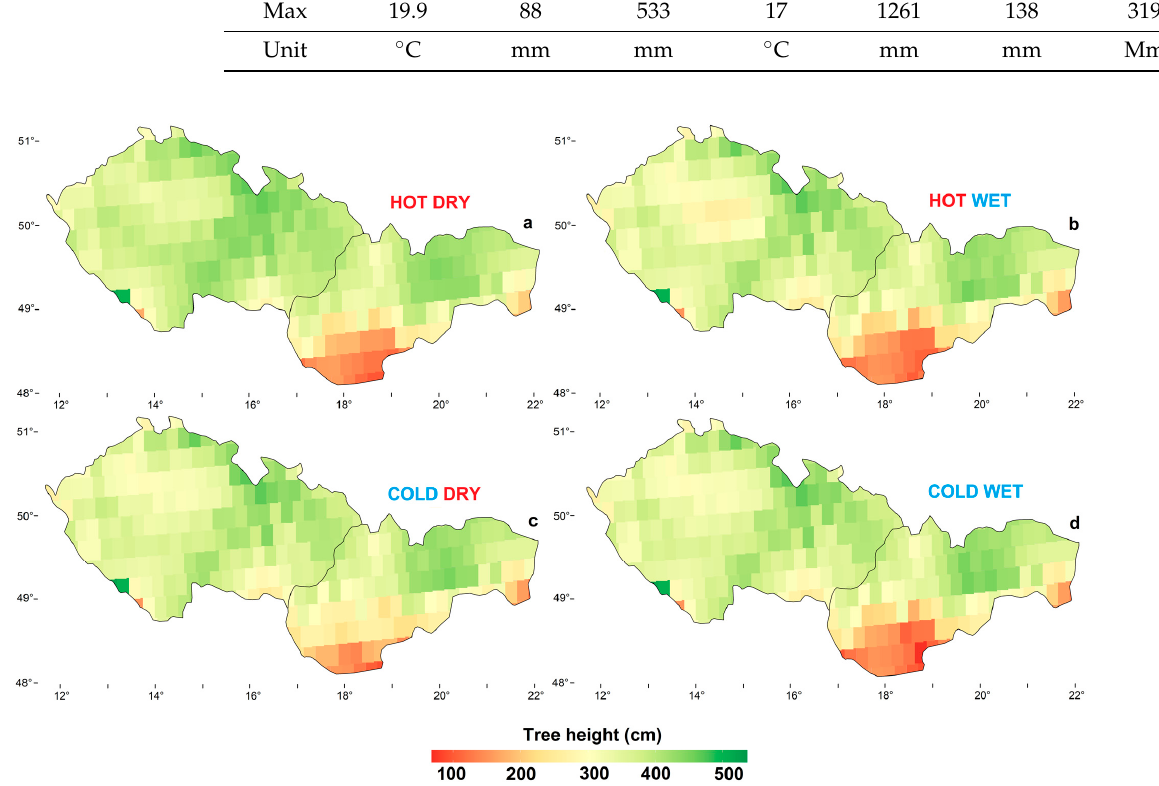
Figure 5. Maps of simulated height growth for four contrasting provenance groups during seven years under 2040–2060 climate derived from the SSP245/RCP4.5 climate scenario ( a —hotdry origin,